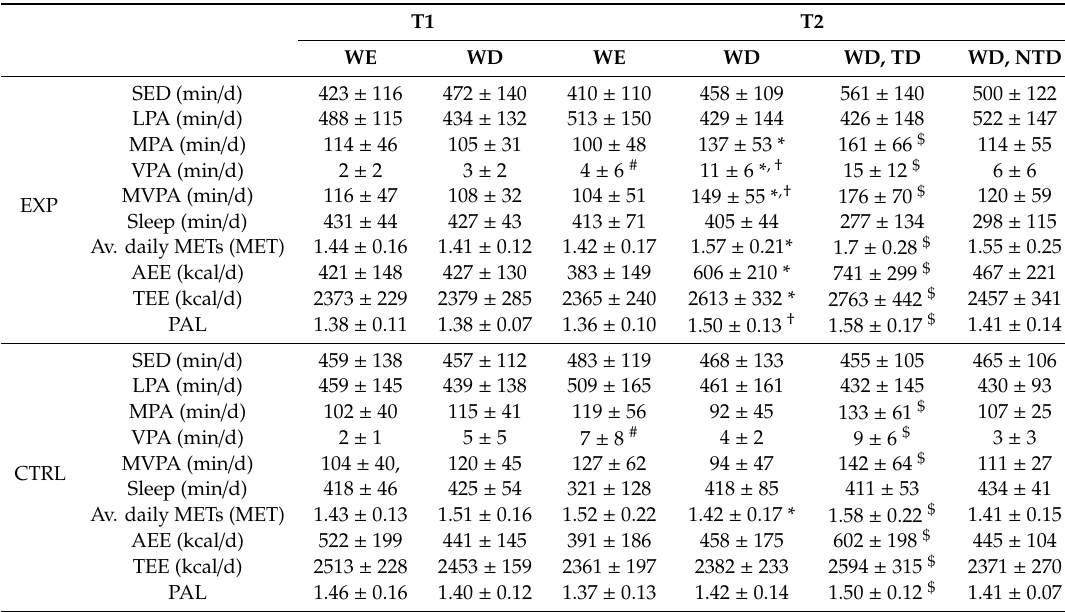
Table 3. Energy expenditure and physical activity maintained during weekly (WD) and weekend (WE) days in T1 and T2. In T2, weekdays were split into training (WD, TD) and non-training (WD, NTD) days (mean ±